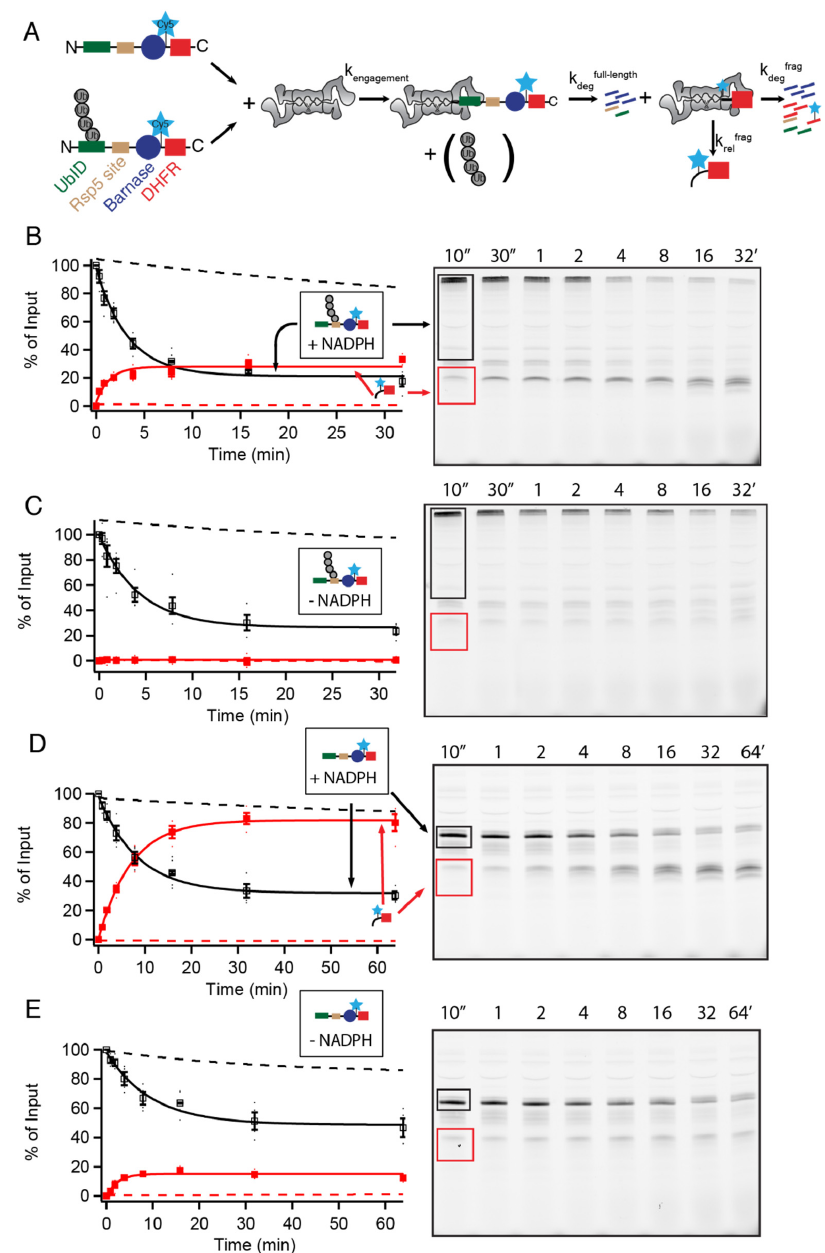
Figure 1. Proteasomal unfolding ability depends on targeting mechanism and substrate stability. ( A ) Unfolding ability assay where proteasome degradation proceeds with the engagement of ubiquitinated or nonubiquitinated substrate (k engagement ), unfolding and degrading of barnase (k degfull-length ), and then either irreversible release (k relfrag ) or degradation (k degfrag ) of DHFR. The ratio of k deg to k rel describes the unfolding ability (U) of the proteasome. ( B – E ) Degradation of 20 nM ubiquitinated ( B , C ) or nonubiquitinated ( D , E ) Rpn4 1–80 -PPXY-Barnase ∆ KL89G-C-DHFRk ∆ C by 100 nM WT proteasome in the presence ( B , D ) or absence ( C , E ) of 500 µ M NADPH. Example gels show full-length substrate outlined in black and DHFR fragment outlined in red. Full-length (open squares) and DHFR fragment (closed squares) are shown as a percentage of total full-length present at the beginning of the reaction; full length is quantified as the sum of ubiquitinated and nonubiquitinated substrate so any deubiquitination is not misinterpreted as degradation. Dots are the results from individual experiments and error bars represent the SEM of 4–5 experiments. Dashed lines are fits in the absence of proteasome from Figure